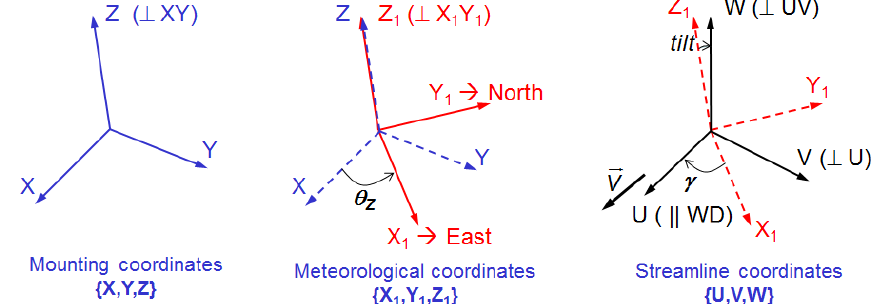
Figure 3. Schematic description for the rotation process.